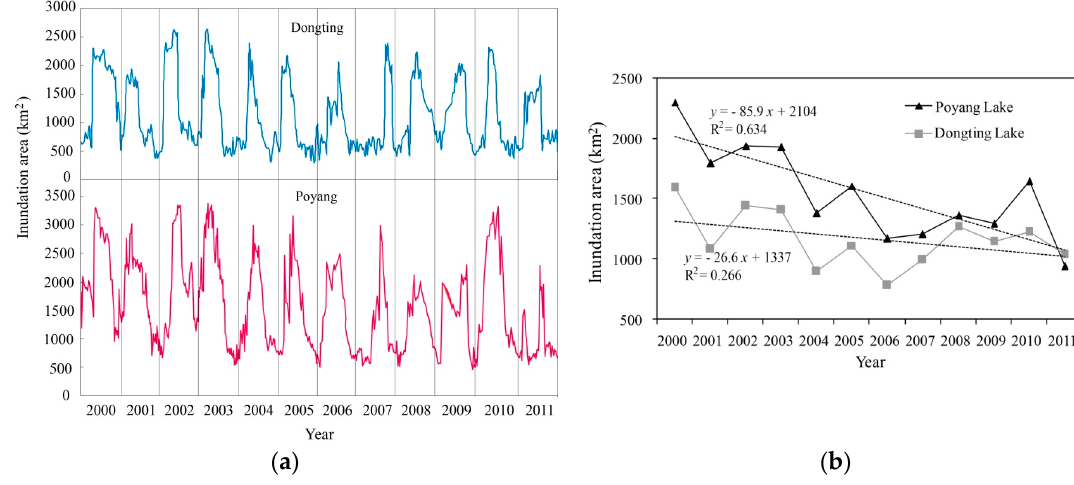
Figure 3. Variations in the inundation areas of Poyang Lake and Dongting Lake during 2000–2011: ( a ) time series of the water inundation area; and ( b ) average inter-annual water inundation area.